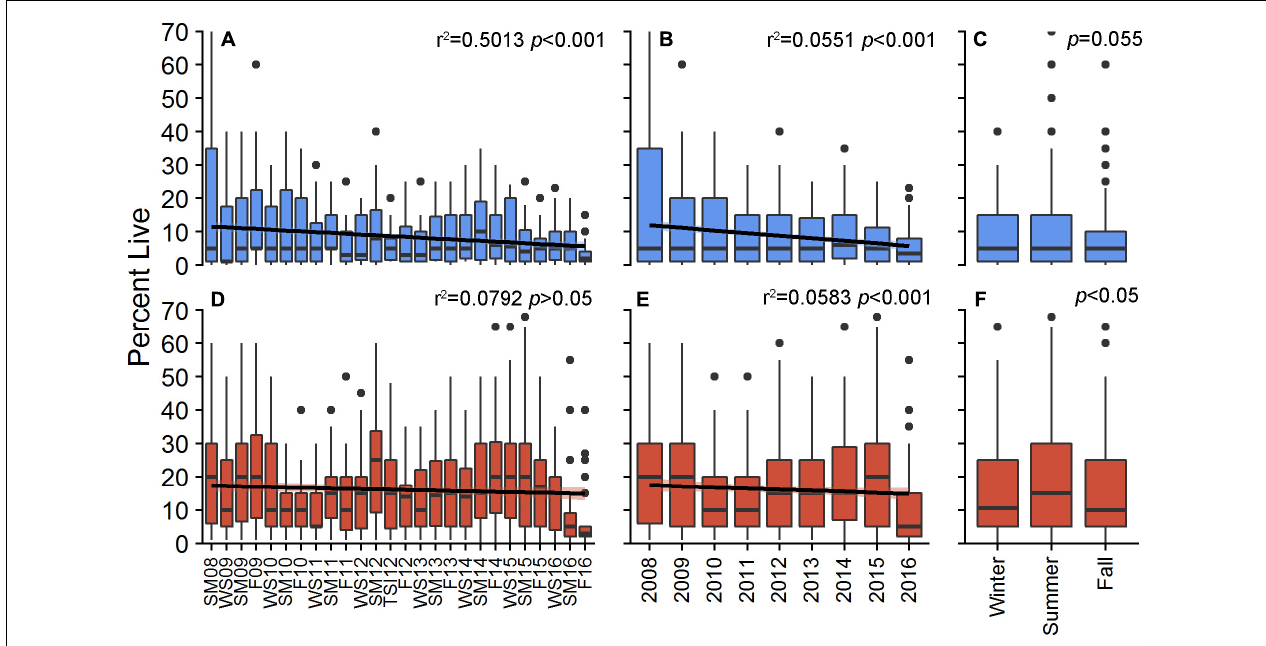
FIGURE 1 | Percent live cover of Acropora cervicornis per plot for BCA (blue) and Scooter (red) across monitoring periods (A,D) , annually (B,E) , and seasonally (C,F) . Boxes represent the 25 and 75% quartiles with whiskers extending 1.5 ∗ interquartile range, the line represents the median, and dots are considered outliers.